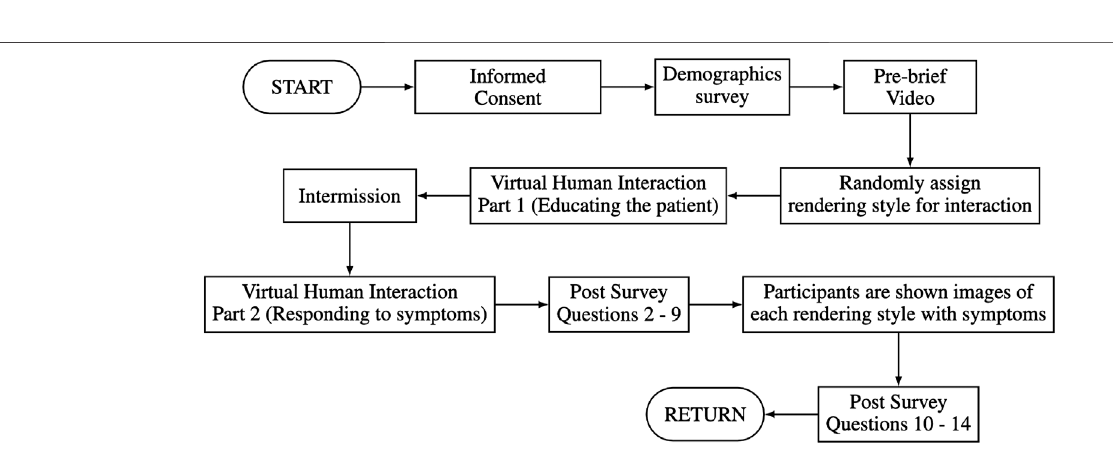
FIGURE 4 | Procedure followed by